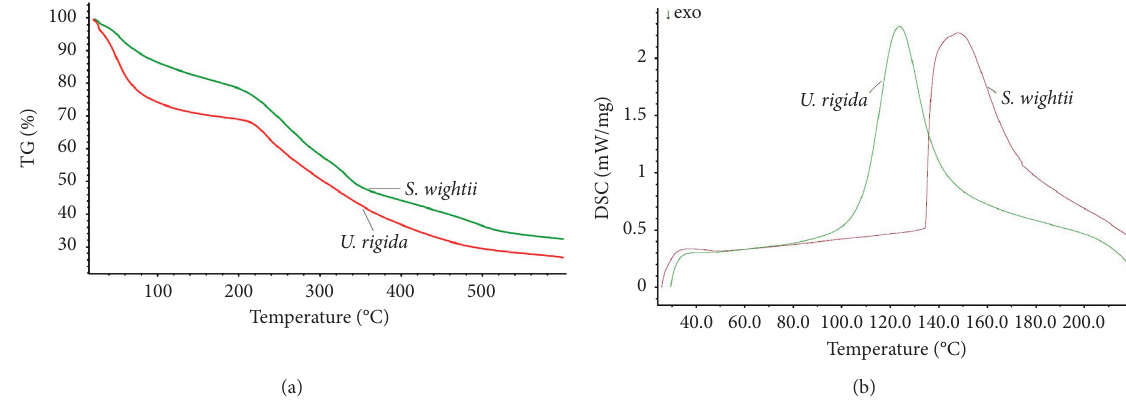
Figure 2: Thermograms of S. wightii and U. rigida from (a) TGA (20 ° C to 600 ° C) and (b) DSC (25 ° C to 250 ° C). Table 4: FTIR absorption frequencies and functional group of Sargassum wightii and Ulva rigida . Wavenumber Functional group Compounds